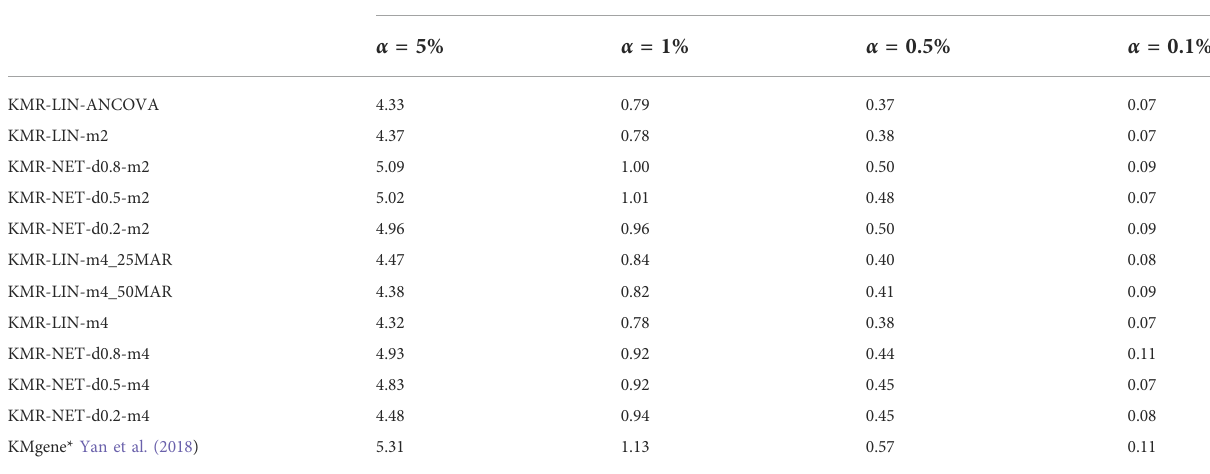
TABLE 3 Type I error rates of the simulation studies.